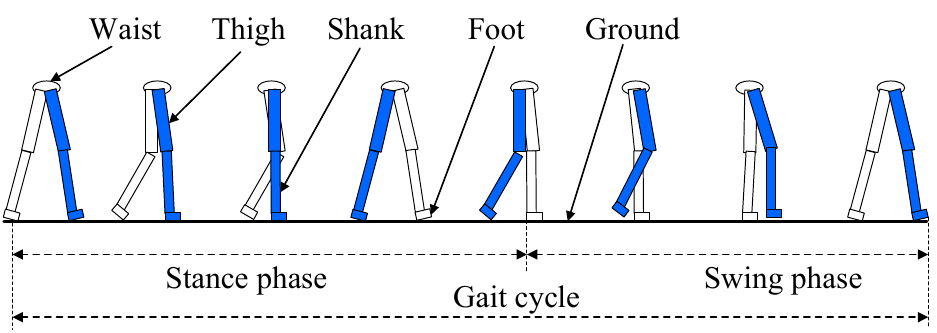
Figure 1. Division of the gait cycle.